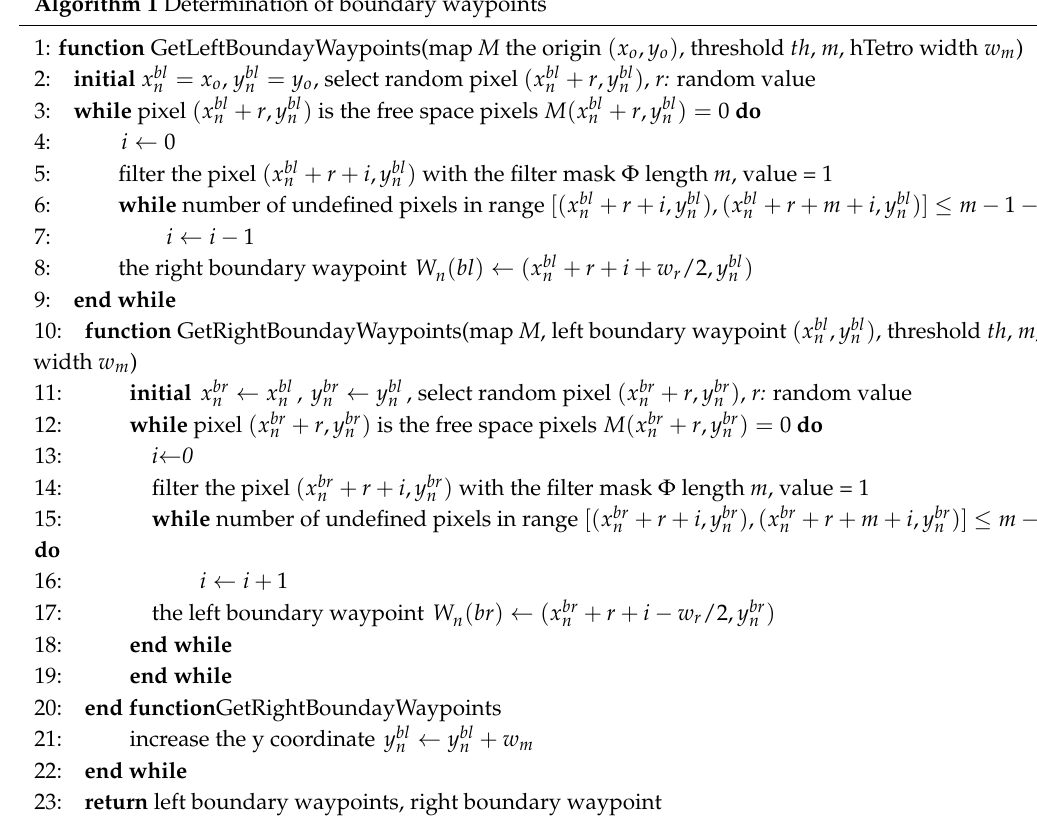
Algorithm 1 Determination of boundary